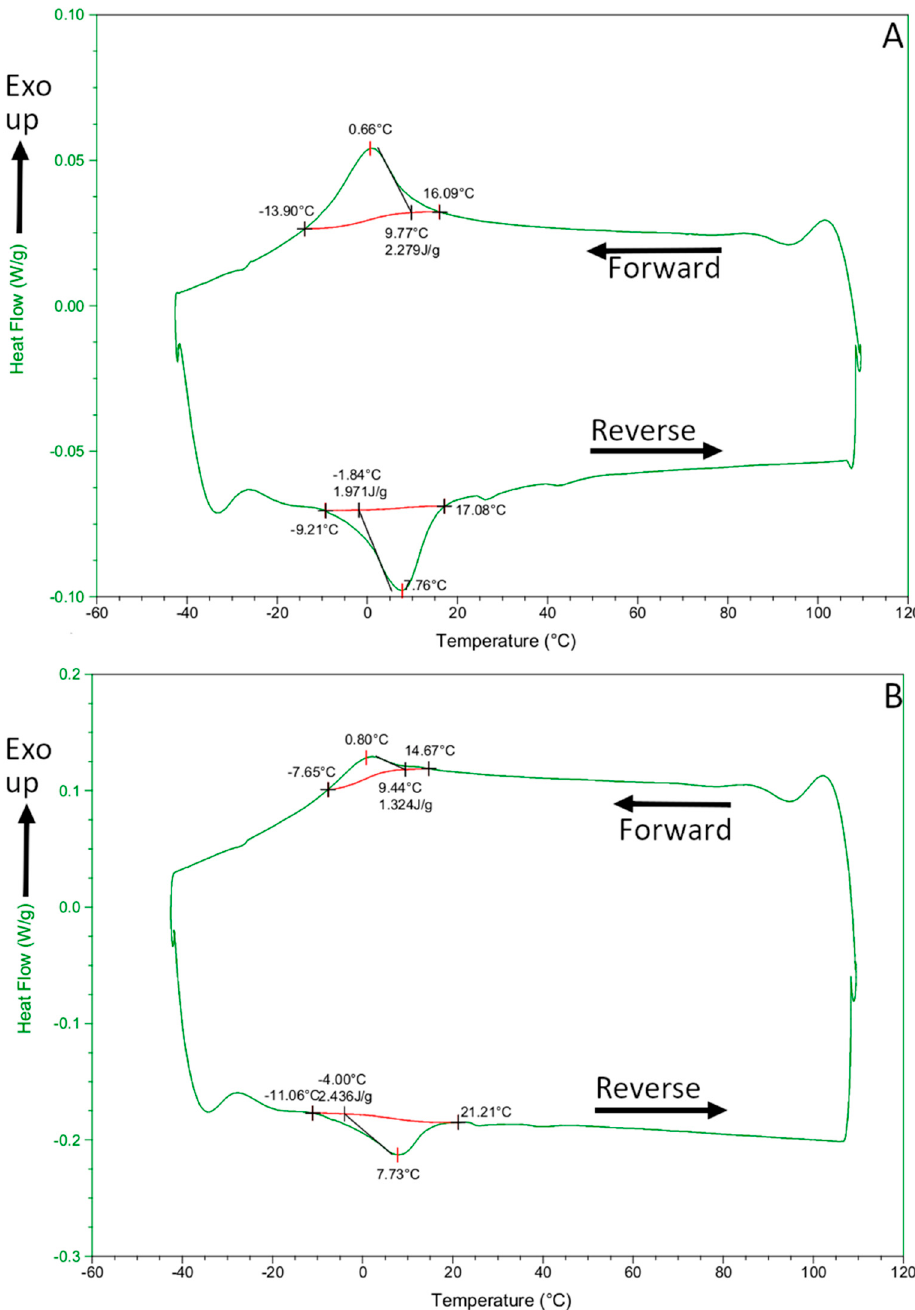
Figure 8. Differential scanning calorimetry (DSC) curves during forward and reverse thermal cycles on Reziflow ( A ) and Procodile ( B ) samples. Table 3. Average phase transformation temperature and enthalpy changes ( ∆ H) of the tested instruments.